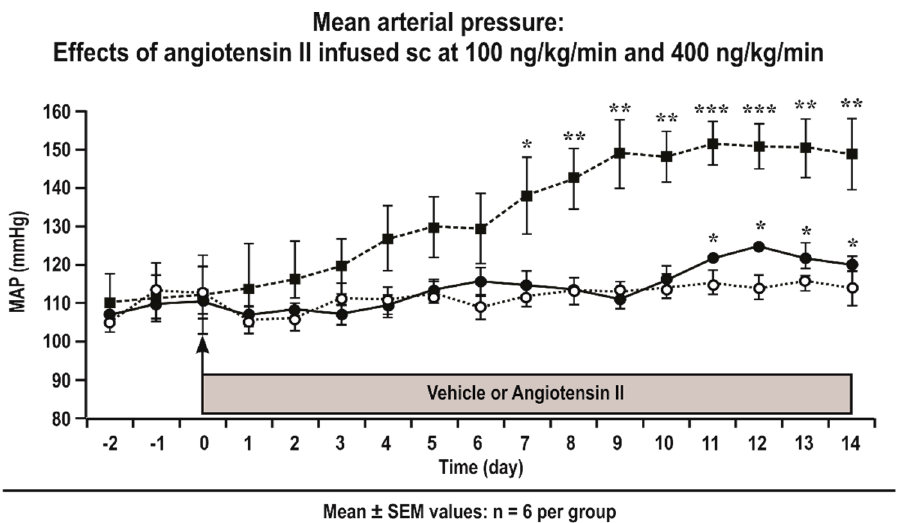
Figure 1. Angiotensin II infusion at 400 ng·kg –1 ·min –1 subcutaneously continuously administration (sc) is a slow pressor model, whereas angiotensin II infusion at 100 ng·kg –1 ·min –1 sc is a sub-threshold model. The daily average 24 hrs mean arterial pressure (MAP) was measured telemetrically in groups of eight conscious C57Bl/6 mice infused subcutaneously with angiotensin II at 400 ng·kg –1 ·min –1 (solid boxes and dashed lines) or 100 ng·kg –1 ·min –1 (solid circles and continuous lines) and sham-infused mice (open circles and dotted lines). Significance of change from sham: *, P < 0.05; **, P < 0.01; ***, P < 0.005.